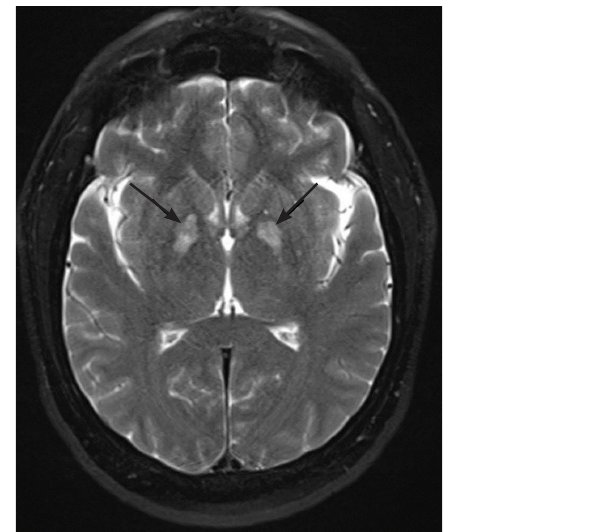
Image 2. Brain magnetic resonance T2/fluid attenuated inversion recovery with evidence of bilateral globus pallidus ischemia